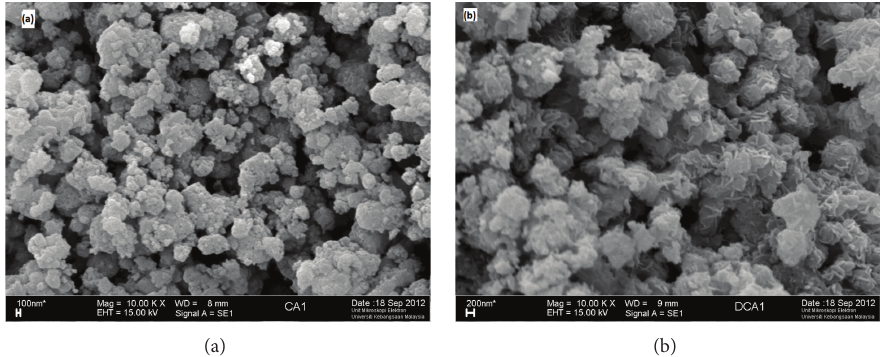
Figure 10: FESEM images for (a) CaO nanocatalysts fabricated with surfactant and (b) alumina supported CaO nanocatalysts.